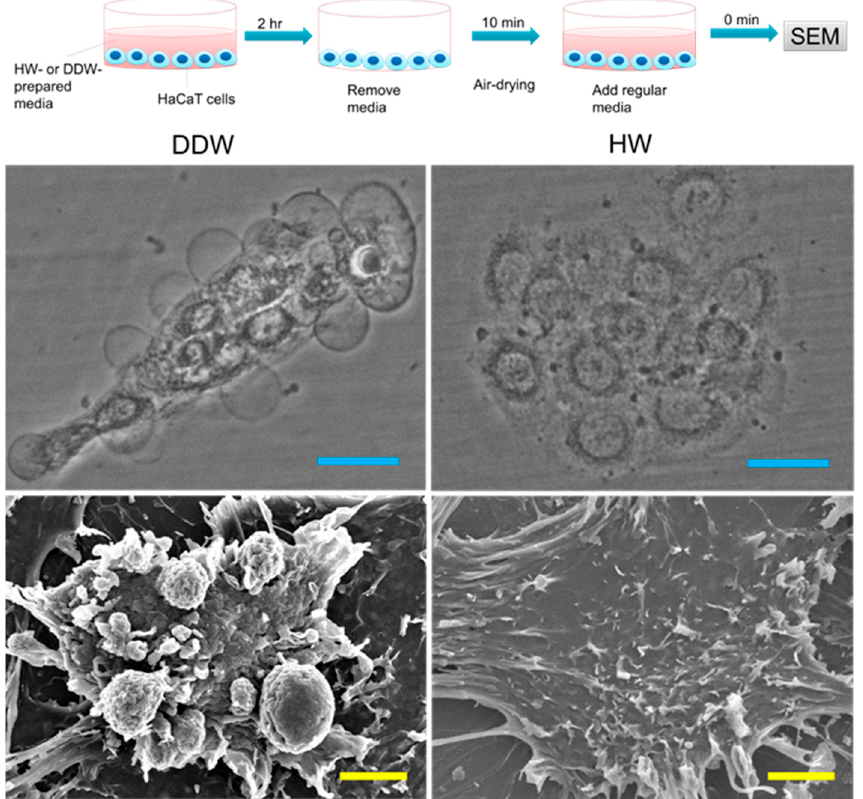
Figure 4. Preventive effects of HW on dehydration-induced apoptosis-like cell death in HaCaT keratinocytes.